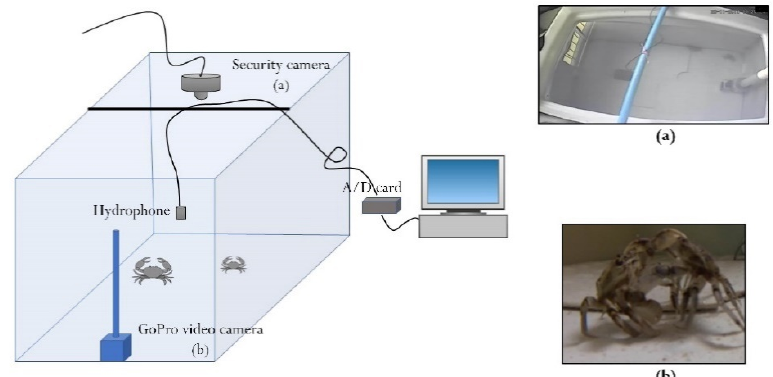
Figure 1. Schematic draft of experimental set-up including video frame collected by ( a ) external security camera and ( b ) GoPro video camera.